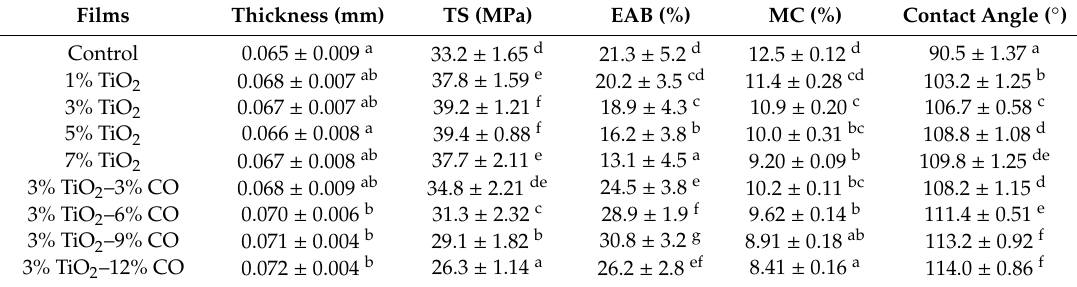
Table 1. Physical and mechanical